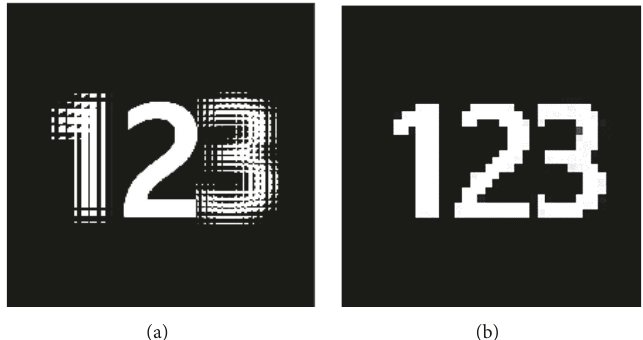
Figure 1: (a) Binary BW integral image of digits 800 x 800 pixels (credits for the original colour image to Prof. B. Lee, SNU); (b) the central view (CV) of this image (as seen through the camera located behind the central microlens of the lens array) 40 x 40 pixels. Wavelet coeff. (A.U.) Wavelet coeff. (A.U.)